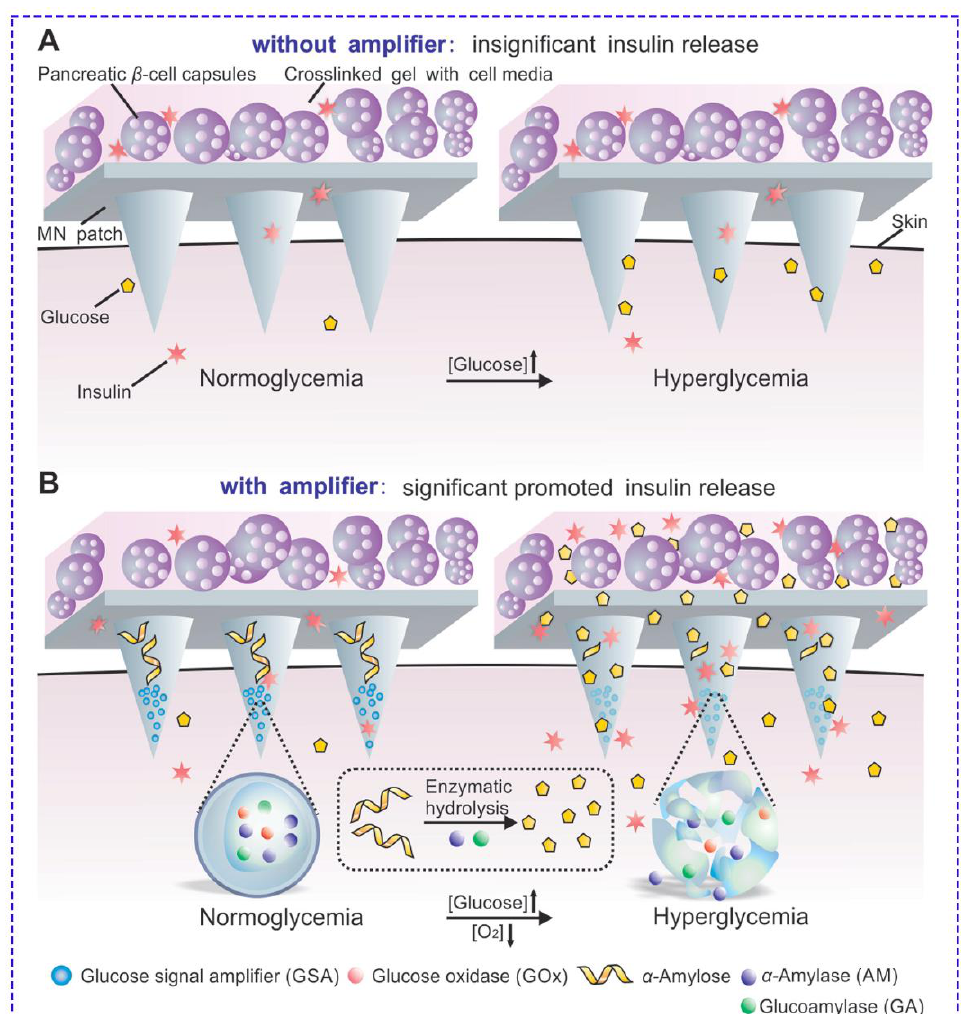
Figure 8. ( A ) Live glucose-responsive design based on the diffusion of glucose in cross-linked hyaluronic acid and stimulation of cells. Unfortunately, no significant release was observed at different glucose concentrations due to the low glucose diffusion in MNs. ( B ) Living-synthetic responsive system with amplified glucose levels, aided by nanovesicles containing three enzymes. After sensing local hyperglycemia, the reaction by glucose oxidase occurs, which results in a decrease in pH and leads to low O 2 levels. Thus, hypoxia-sensitive nanoparticles dissociate, resulting in the release of a ll enzymes. Released α - amylase and glucoamylase convert α -amylose to glucose in two separate steps. Higher amounts of glucose diffuse and make the living part of the system secrete insulin effectively. Reprinted with permission from [134].